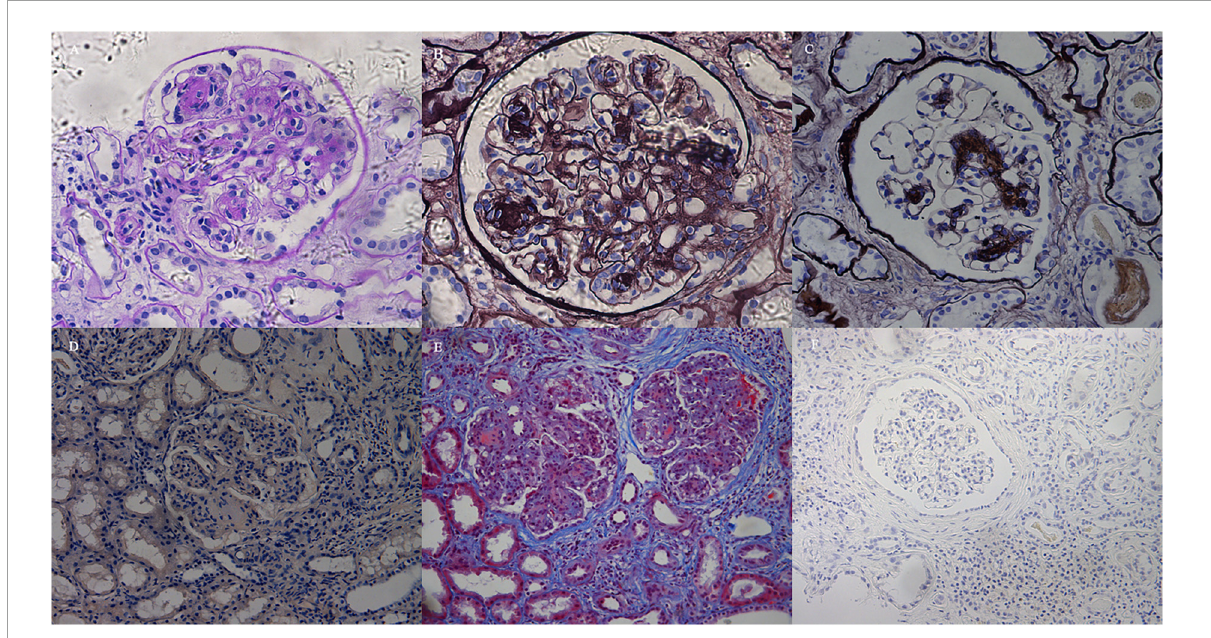
FIGURE1 Light microscopy findings. (A) The glomerulus exhibited mesangial expansion and extensive proliferation of mesangial cells and matrix, with mesangial nodular sclerosis. The nodules and tubular basement membranes were periodic acid–Schiff (PAS) positive (Patient 3, PAS; × 200). (B) Diffuse membranoproliferative-like features revealed GBM duplication and mesangial interposition with double-contour or multicontour appearances (Patient 3, PASM; × 400). (C) The glomerulus exhibited segmental nodular sclerosis with mild mesangial hypercellularity. The GBMs in non-sclerotic areas were not thickened (Patient 4, PASM; × 200). (D) Congo red staining was negative (Patient 2, Congo red staining; × 100). (E) The mesangium expanded with diffuse hypercellularity and mesangial matrix proliferation. There was tubular atrophy and multifocal infiltration of lymphocytes and monocytes in the interstitium with fibrosis (Patient 2, Masson; × 100). (F) Lymphocytes and monocytes infiltrating the interstitium were CD38-negative by immunohistochemical staining (Patient 3, CD38; × 100).